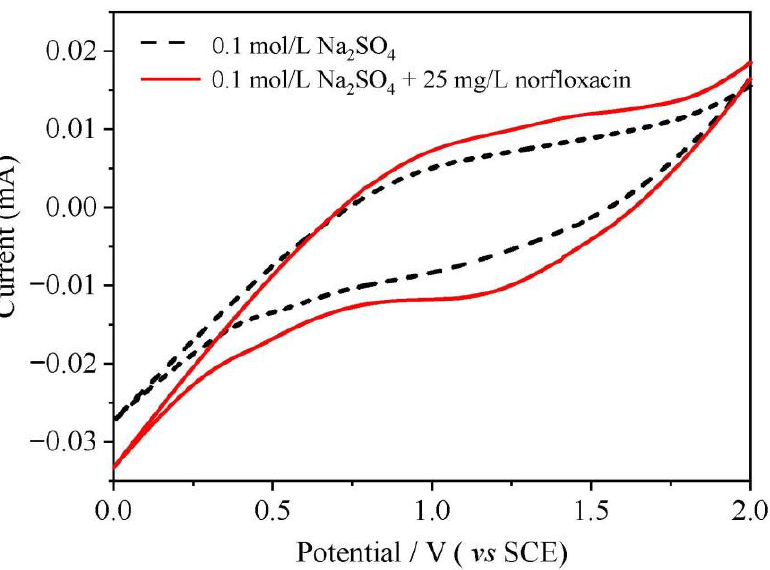
Figure 4. Cyclic voltammograms of PbO 2 -FN electrode in 0.1 mol/L Na 2 SO 4 solution and 0.1 mol/L Na 2 SO 4 + 25 mg/L norfloxacin solution.